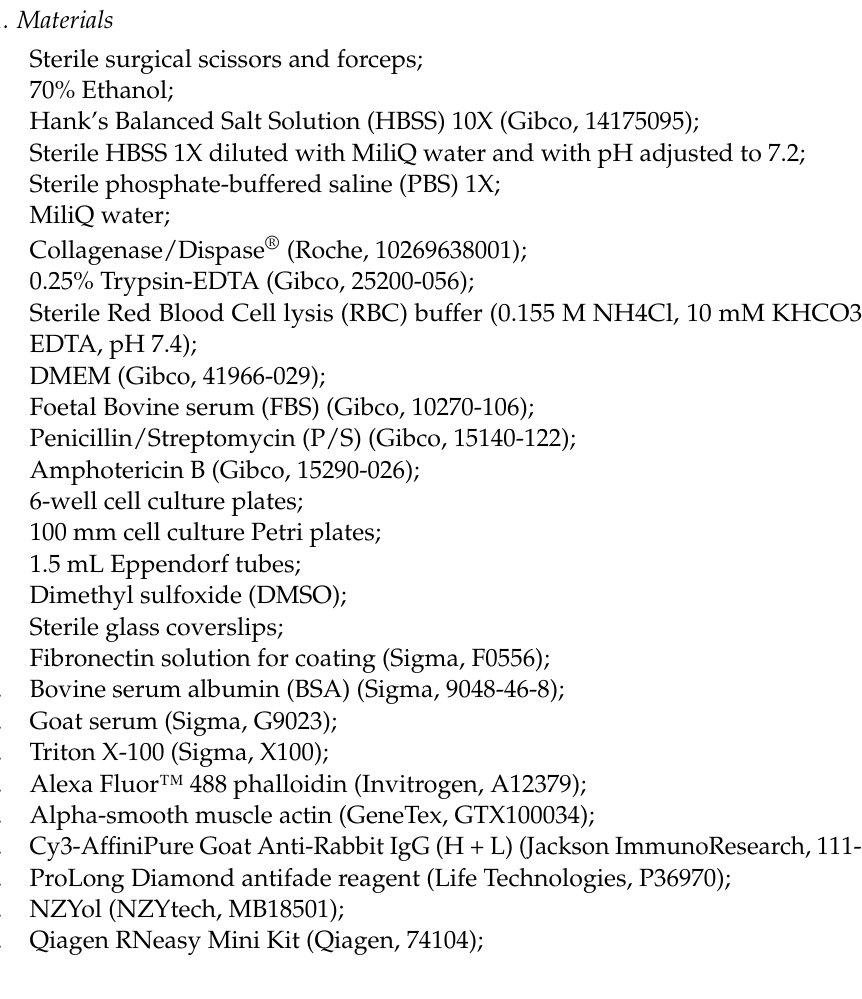
Figure 1. Experimental design of the protocol. Collagenase/Dispase (Col/Disp). Red arrows on 6-well culture plates represent lung tissue pieces from which lung fibroblasts will crawl-out.